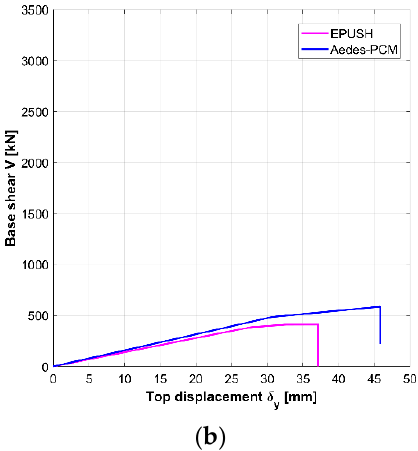
Figure 13. Comparison of capacity curves provided by Aedes PCM and E ‐ PUSH for the wall align ‐ ment no. 9 in Figure 9: ( a ) model of the wall alignment, ( b ) capacity curves. On the basis of the abovementioned results, the seismic risk index 𝐼 (cid:3019) given by E ‐ PUSH, i.e., the minimum ratio between the maximum peak ground acceleration resisted by the alignments and the design peak ground acceleration in the actual condition, is 𝐼 (cid:3019) (cid:3404)